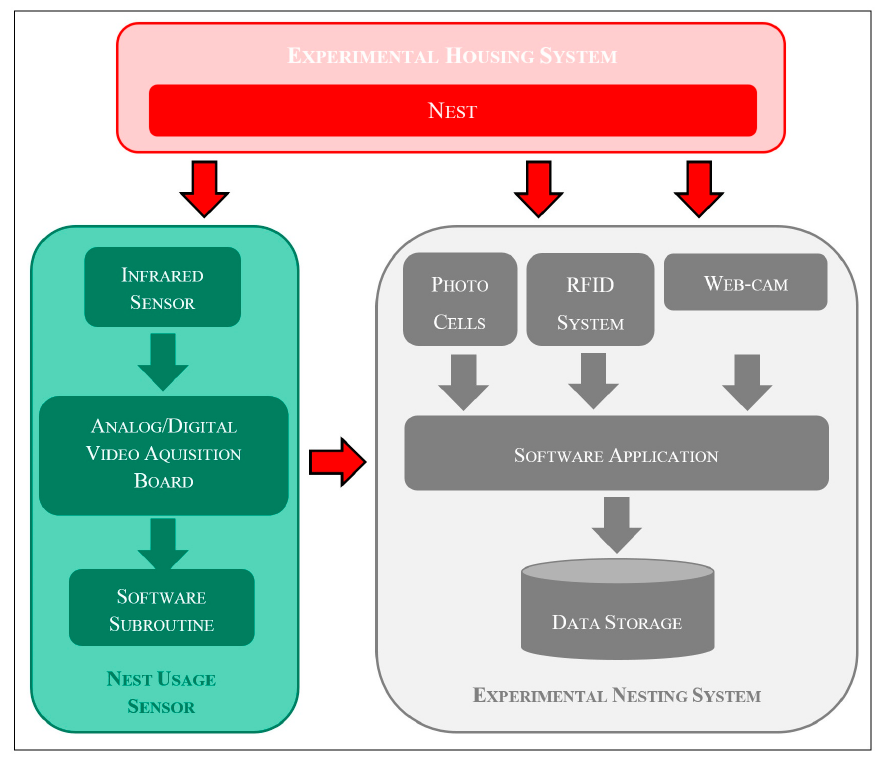
Figure 3. Functional schema of the hardware and software components of the “nest usage sensor” with their connections to the other main components of the experimental nesting system.